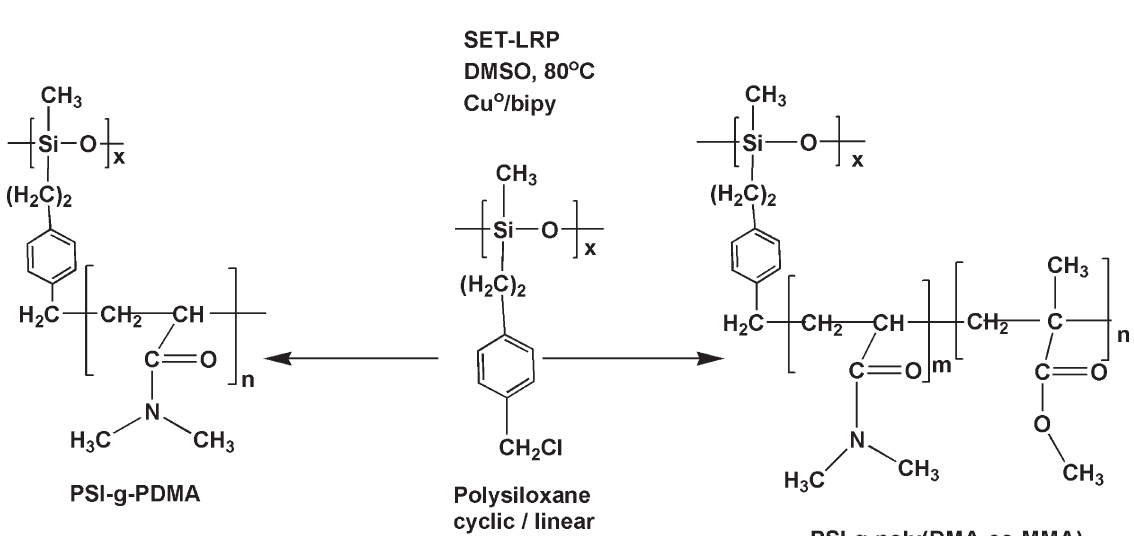
Scheme 1. Synthesis of graft